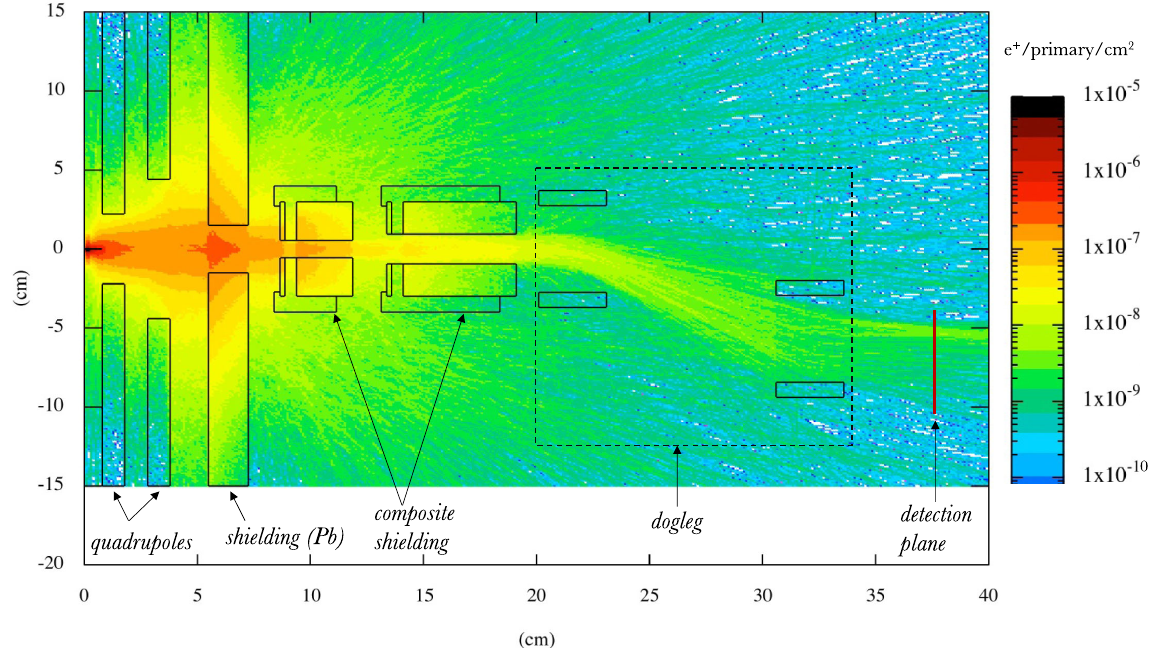
FIG. 5. Top-view of the spatial distribution of the positron beam through the whole system, as simulated by the Monte-Carlo scattering code FLUKA . The colorbar is in logarithmic scale and it is in units of positrons per primary electron per cm 2